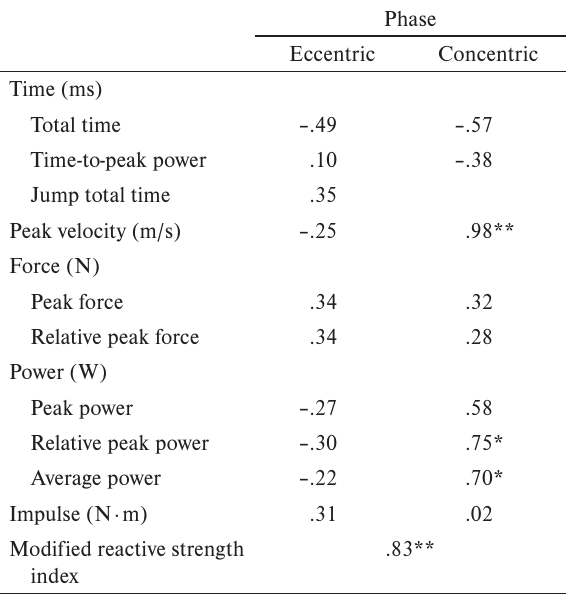
Correlation between jump height and F-T curve variables in the eccentric and concentric phases of